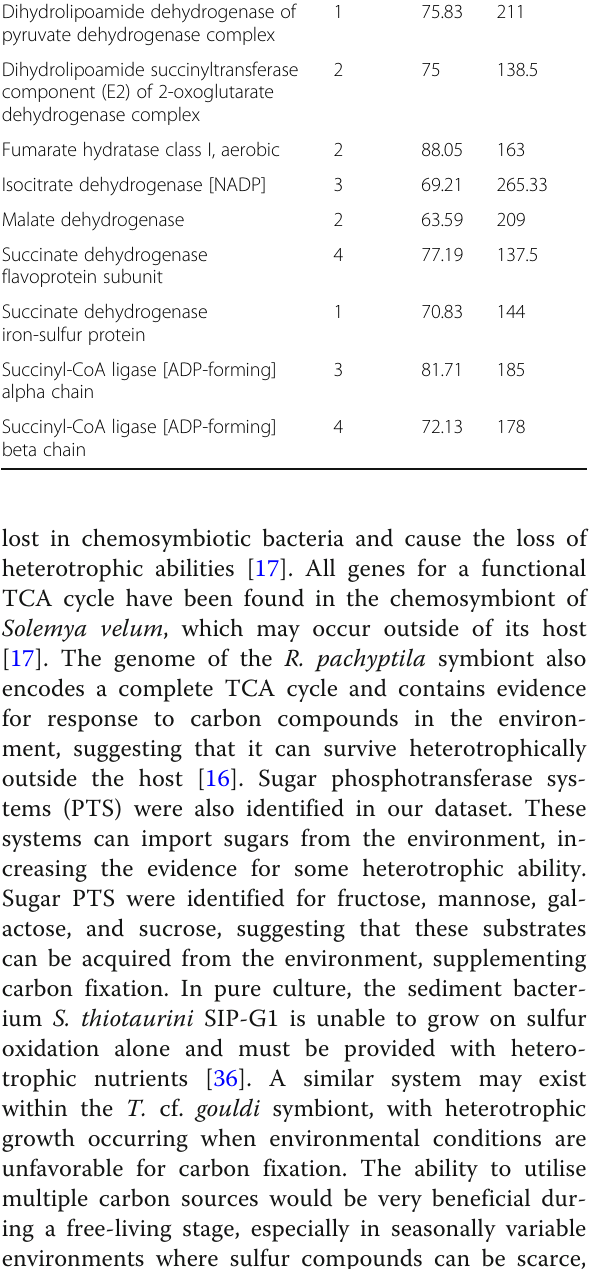
Percent Alignment of copies identity length